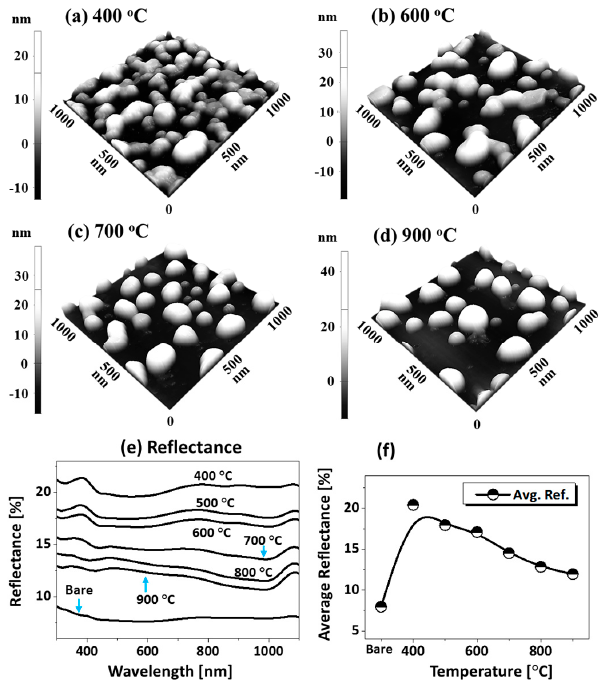
Figure 7. ( a – d ) Enlarged side-views of specific samples from Figure 6 showing the typical surface morphology of AuAgPd NPs at different temperatures, as labeled. ( e ) Reflectance spectra. ( f ) Summary of average reflectance with respect to the temperature.